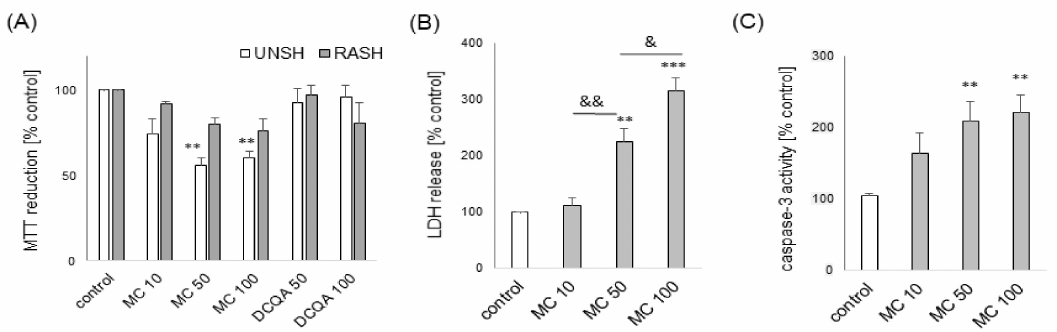
Figure 2. ( A ) The e ff ect of MC (10–100 µ M) or 3,5-DCQA (50 and 100 µ M) on cell viability of undi ff erentiated (UN-) and retinoic acid-di ff erentiated (RA-) SH-SY5Y cells after 24 h of treatment (measured with MTT reduction assay). ( B ) The cytotoxic e ff ect of MC (10–100 µ M) in UN-SH-SY5Y cells after 24 h of treatment as measured with LDH release assay. ( C ) The e ff ect of MC (10–100 µ M) on caspase-3 activity in UN-SH-SY5Y cells after 9 h of treatment. Data were normalized to vehicle-treated cells and are presented as the mean ± SEM. *** p < 0.001 and ** p < 0.01 vs. vehicle-treated cells; && p < 0.01 and & p < 0.05 a higher vs. lower concentration of MC. Of the two tested ca ff eic acid derivatives at wide range of concentrations (0.1–50 µ